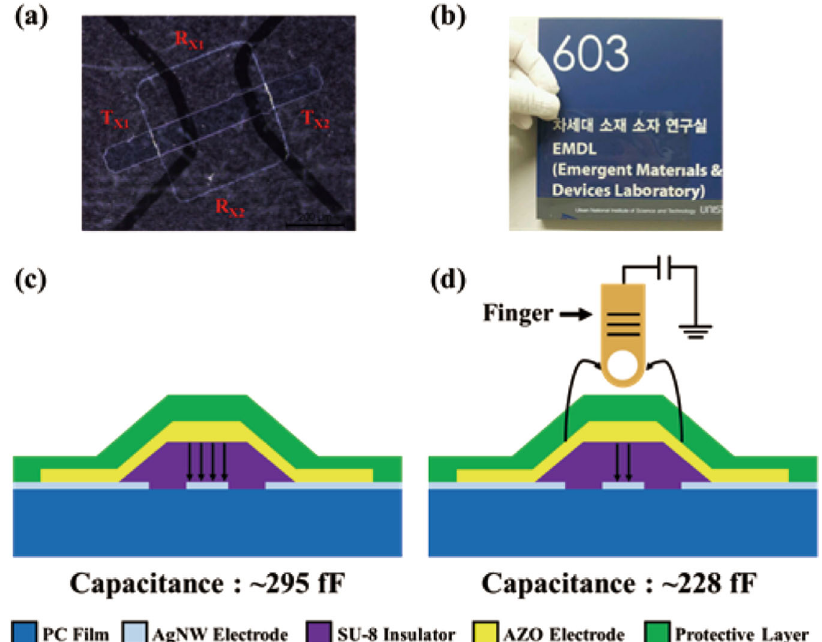
Fig. 4 a Dark- fi eld optical microscope image of fabricated TSP sample showing the AgNW diamond-pattern electrodes (Rx, Tx), SU-8 bridge insulator, and AZO bridge electrode. b Photo demonstrating the transparency of the fabricated TSP sample and a schematic of the working principle of the fabricated TSP: electric fi eld line con fi gurations and measured capacitances c before and d during touching. a – d Reproduced with permission from ref. 26. Copyright 2015, Optical Society of